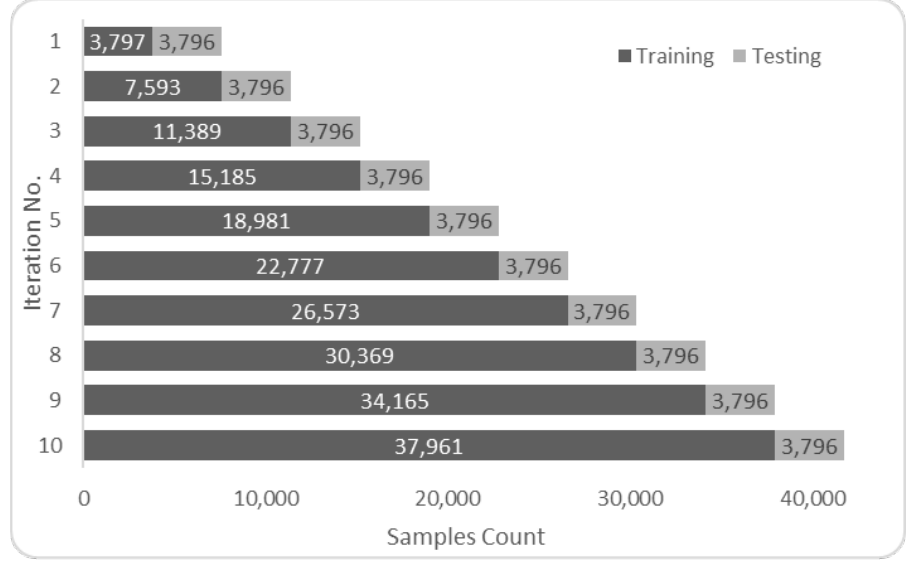
Figure 8. A sample dataset showing how data shifting is done for two look-back hours.